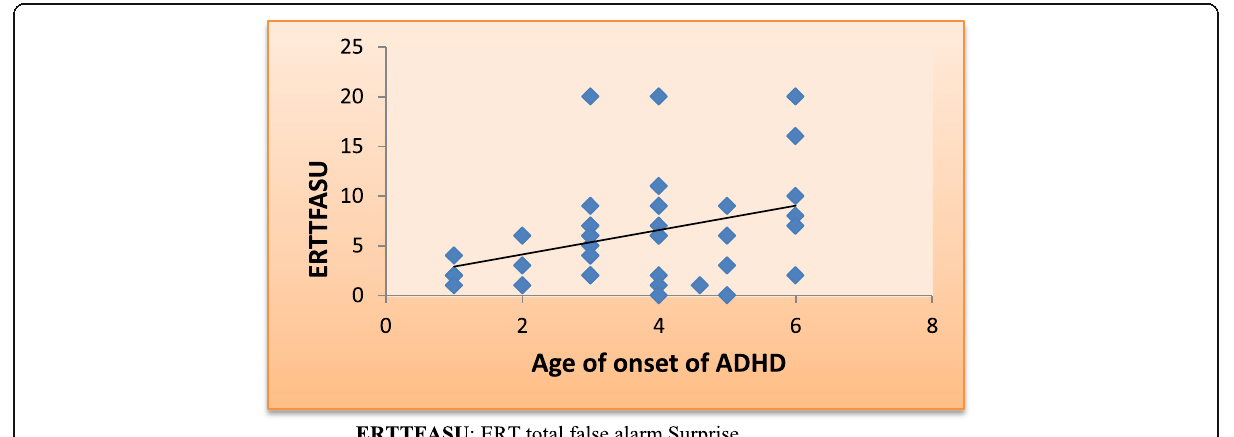
Fig. 4 Scatter chart showing positive correlation between age of onset of ADHD and